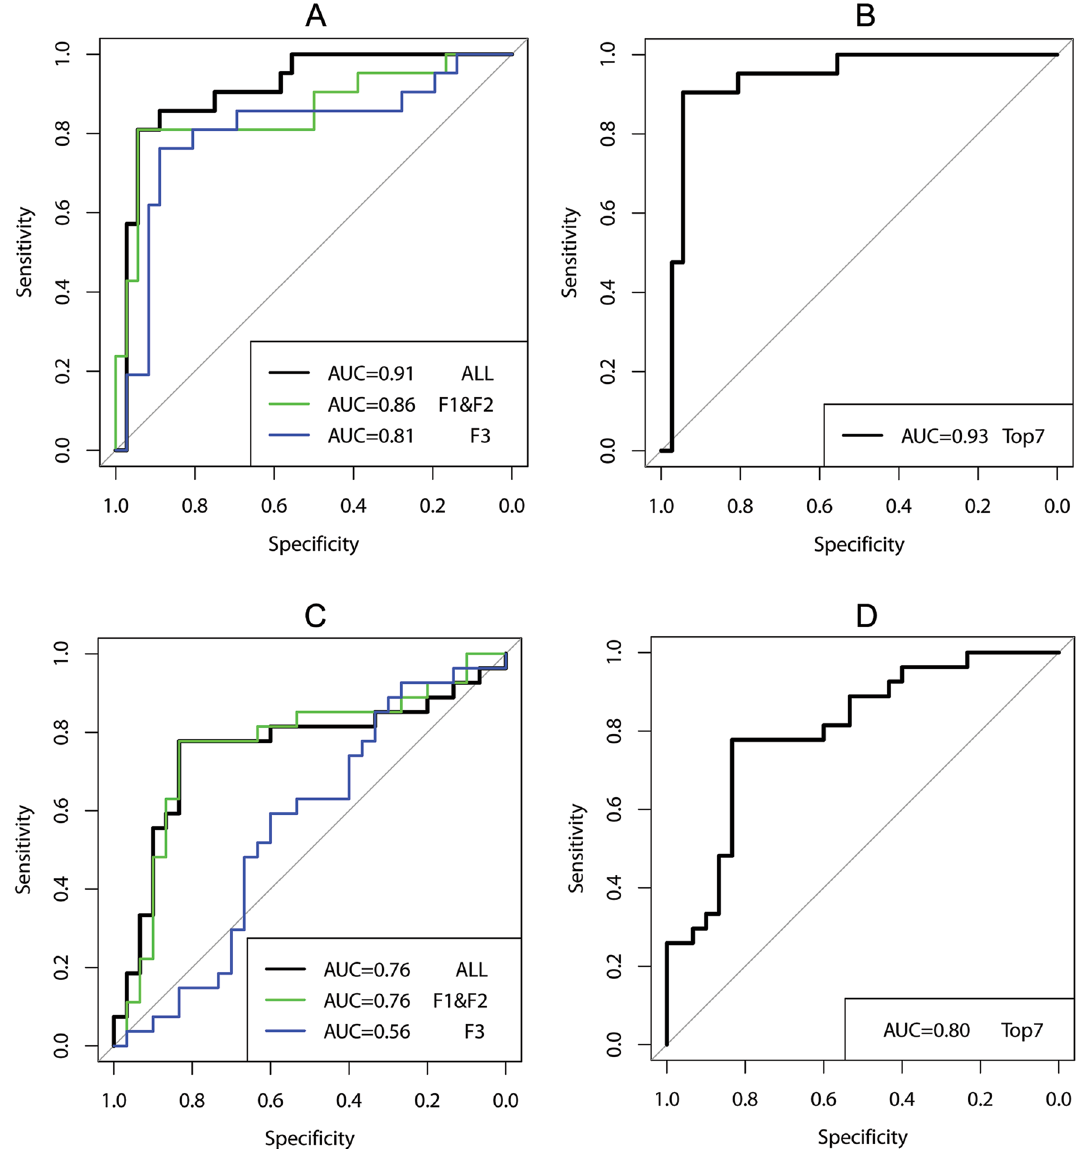
Figure 8. ROC curves for the prediction of the level of kidney function ( A , B ) at the biopsy and ( C , D ) in the future. F1, F2, and F3 represent frequency, polynomial fitting coefficients, and clinical features, respectively. Top7 represents the top 7 features selected based on the importance rank. The x-axis is the true negative rate (TNR) or specificity and the y-axis is the true positive rate (TPR) or Visual words #2 and #8 were determined to be the most important visual words for determining the level of the kidney function at the biopsy stage (Table 3). While visual word #2 (blue) has morphological characteristics consistent with an open glomerulus, including both normal and inflamed regions, the morphological char- acteristics of visual word #8 (dark blue) are consistent with interstitial expansion, tubular atrophy, and some cellularity. The most important visual words for predicting the level of kidney function changes in one year are visual word #7 (yellow), with features consistent with normal and nearly-normal tubulointerstitial (TI) with more interstitial expansion, and visual word #8 (dark blue). Table 5 presents a detailed description for each visual word. We selected the top 7 features based on the important feature rank (Table 1); 4 frequency features (f5, f6, f8, and f9), 1 polynomial feature (c1), and 2 clinical features (age and diagnosis). Selecting the top 7 features ensured that all three categories of feature types were included in our analysis. The error from the random forest was 0.07, the sensitivity was 0.94, and specificity was 0.89. The ROC for the top 7 features is illustrated in Fig. 8 (A, right). The AUC was 0.93 and the 95% confidence interval was 0.8605–1.0. The accuracy was 0.93 (Table S2 in the Supplementary Information). For predicting whether eGFR is increased or decreased in one year (eGFR slope), the error from the random forest was 0.19, the sensitivity was 0.83, the specificity was 0.78, and the accuracy was 0.81. The ROC for the top 7 features is illustrated in Fig. 8 (B, right). The area under ROC curve (AUC) was 0.80 and the 95% confidence interval was 0.62–0.89 (Table S3 in the Supplementary Information).